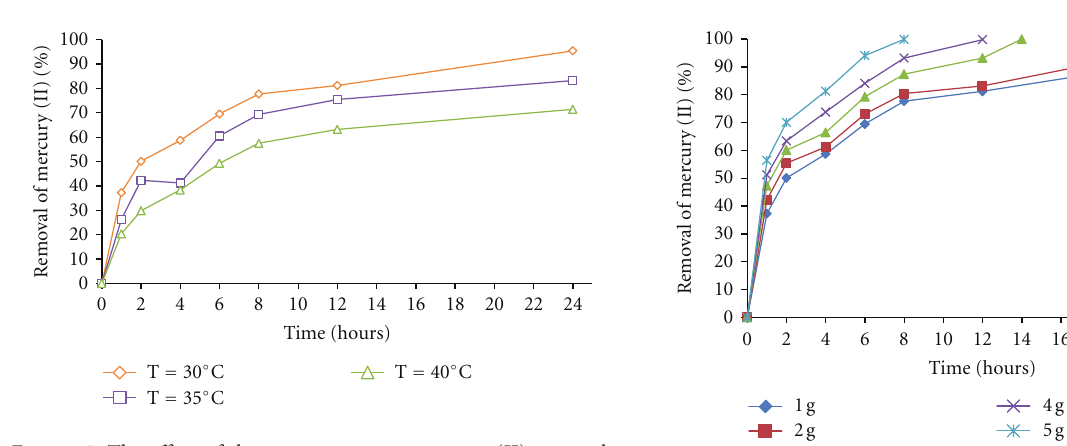
Figure 2: The e ff ect of the temperature on mercury (II) removal. 100mg/L Hg (II), 100rpm. pH 5.5, 1g of fungal biomass of M. rouxii IM-80.